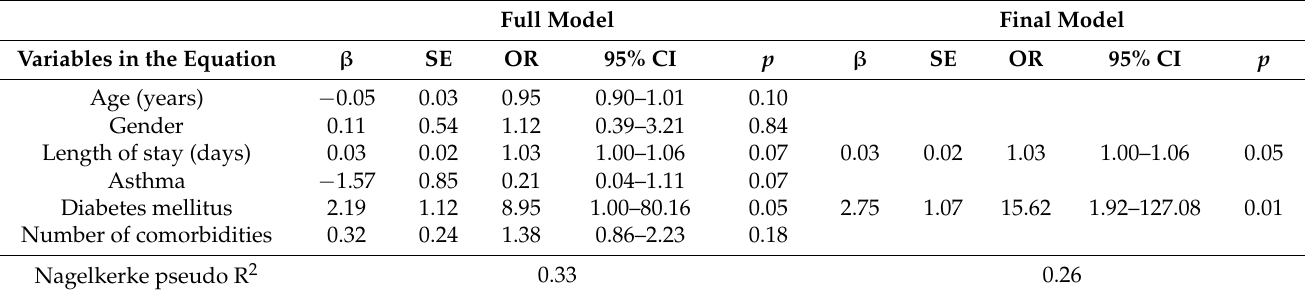
Table 2. Outcomes of logistic backward stepwise regression identifying possible predictors of muscle weakness in post-hospitalized COVID-19 patients.